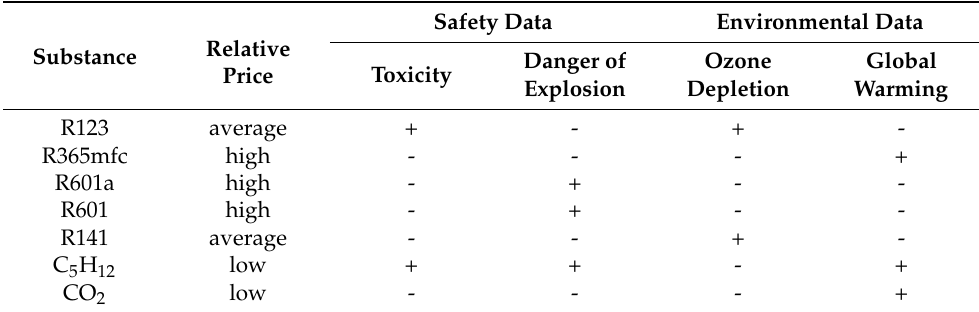
Table 3. Availability, safety, and environmental data of the low-boiling-point fluid.